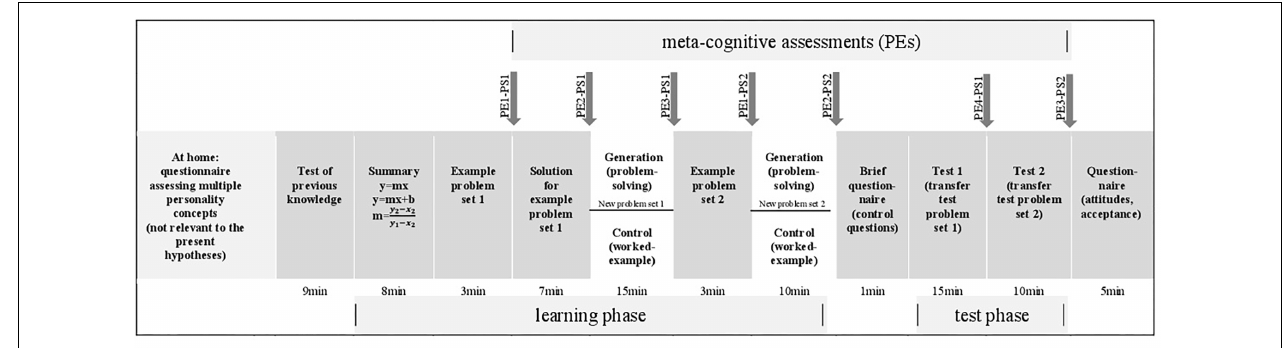
FIGURE 1 | Timeline and schematic design in-class Session Time 1. Gray-colored arrays denote the same procedures and materials for all participants; white arrays show the differing procedures and materials according to the experimental manipulation. PE, performance expectancy; PT, problem set; EP, estimated performance; thus PE1-PS1, performance expectancy measurement 1 for problem set 1; PE2-PS1, performance expectancy measurement 2 for problem set 1; PE3-PS1, performance expectancy measurement 3 for problem set 1; PE1-PS2, performance expectancy measurement 1 for problem set 2; PE2-PS2, performance expectancy measurement 2 for problem set 2; EP1-PS1, estimated performance for problem set 1; EP1-PS2, estimated performance for problem set